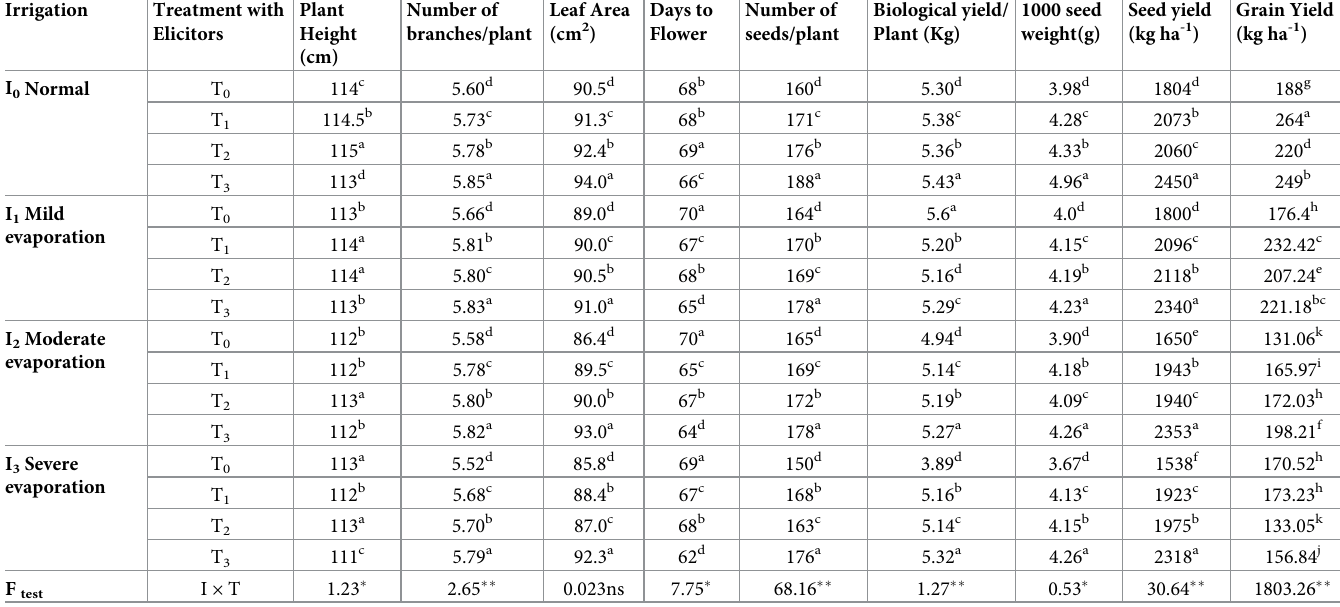
Table 3. Variation in agronomical and yield attributes of canola with fertilizers and plant growth regulators under different water regimes. Irrigation Treatment with